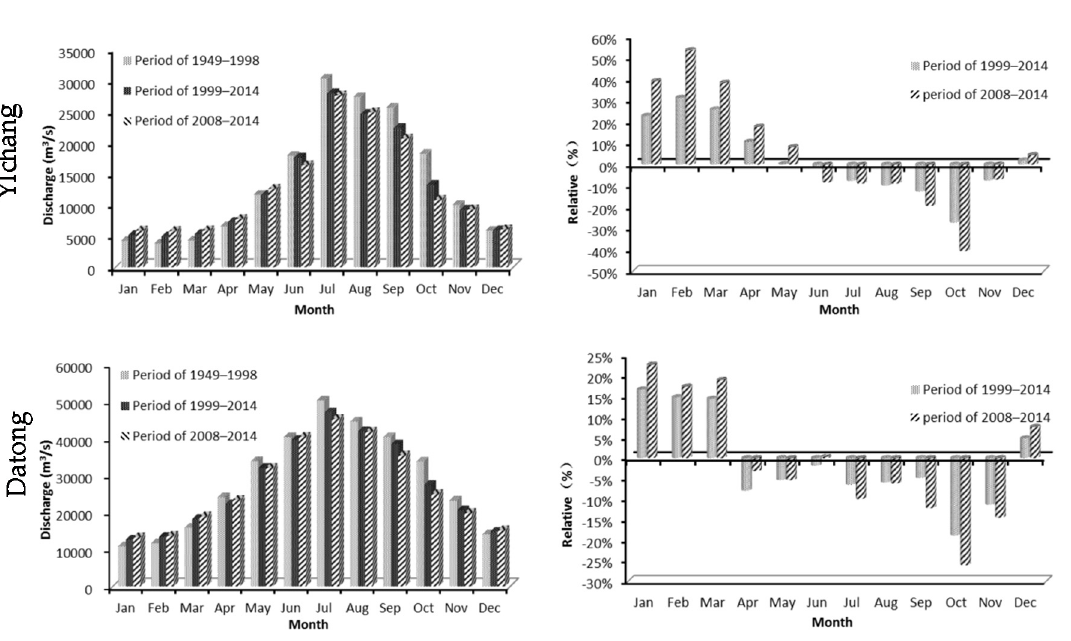
Figure 6. The number of IHA factors that fall into the normal range.